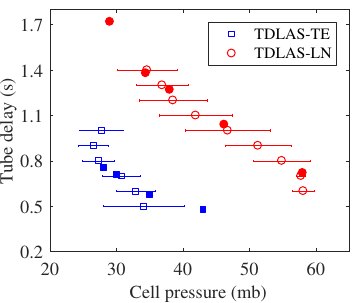
Figure 5. Tube delay ( t del ) determined from the frequency-response test (solid symbols) and from the cross-correlation between the CO 2 and w (open symbols) across the range of operating pressures. Error bars are the standard deviation of the mean cell pressure associated with each